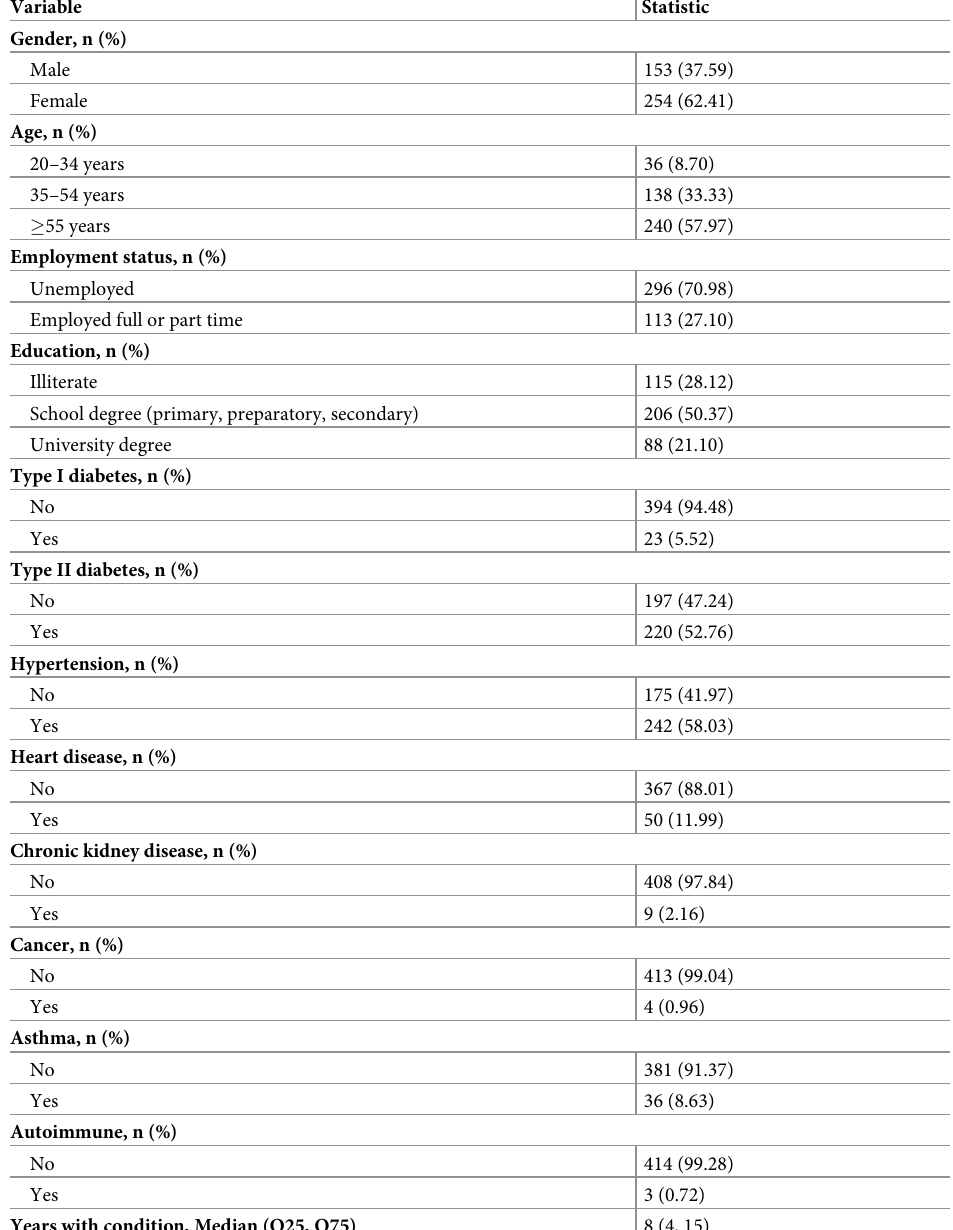
Table 1. Demographic and comorbidities characteristics of patients with chronic disease in the UAE (N =